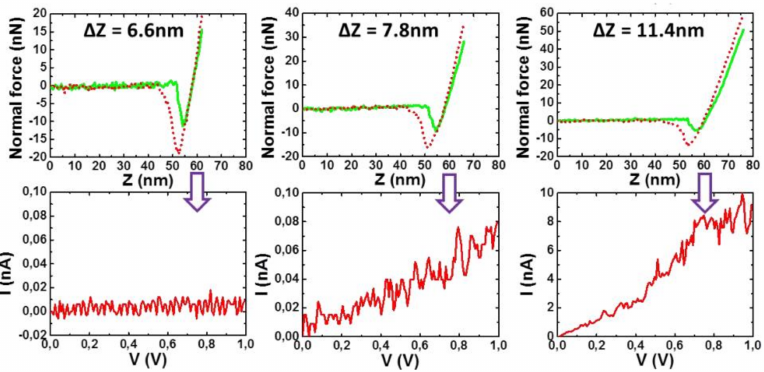
Figure 11. I-V plots (lower curves) vs. penetration depth (upper curves). From left to right: insulator behaviour, appearance of current, semi-conductor behaviour [26]. Copyright 2018 John Wiley & Sons.